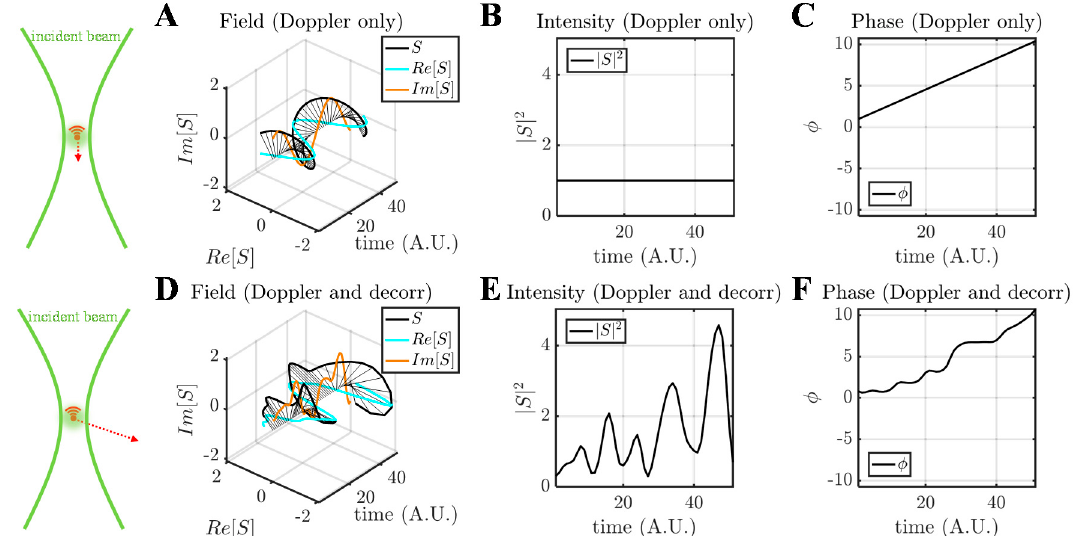
Figure 4. The major categories of OCT signal fluctuations are Doppler shifts and decorrelation. Comparison of complex field, intensity, and phase time courses, for the case of a pure Doppler shift ( A – C ) and a Doppler shift with decorrelation ( D – F ). For a pure Doppler shift, the field traces out a helical pattern ( A ), whereas decorrelation introduces random deviations from this pattern ( D ).